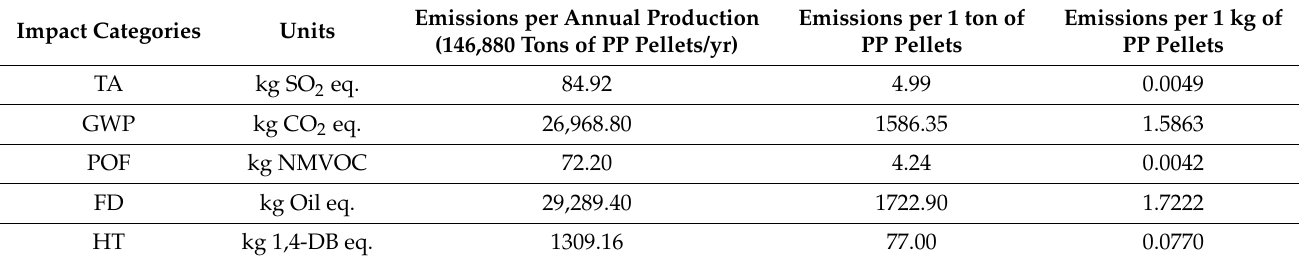
Table 2. Detailed results for the number of emissions released into the atmosphere during the PP manufacturing process (based on functional unit = 1 ton of PP